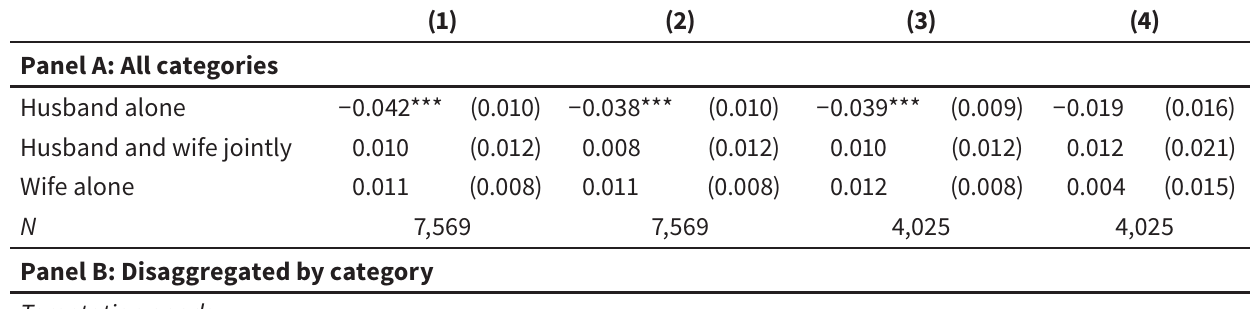
Shifts in decision-making power as son’s migration status